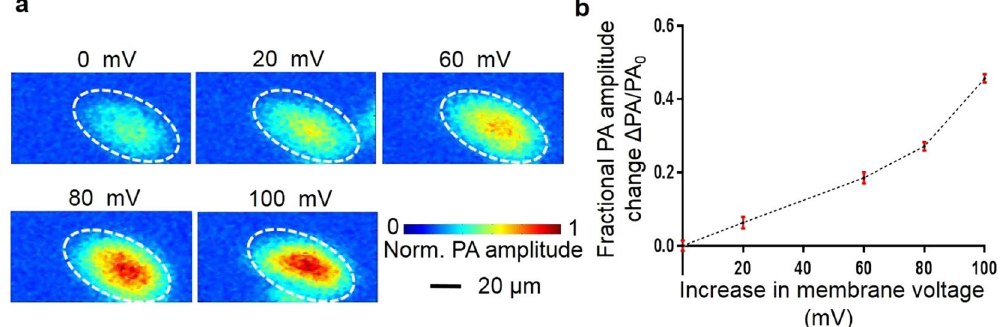
Figure 1. ( a ) Photoacoustic maximum-amplitude projection images of HEK-293 cells demonstrate photoacoustic signal changes due to cell membrane voltage changes. ( b ) Fractional photoacoustic signal change versus cell membrane resting voltage